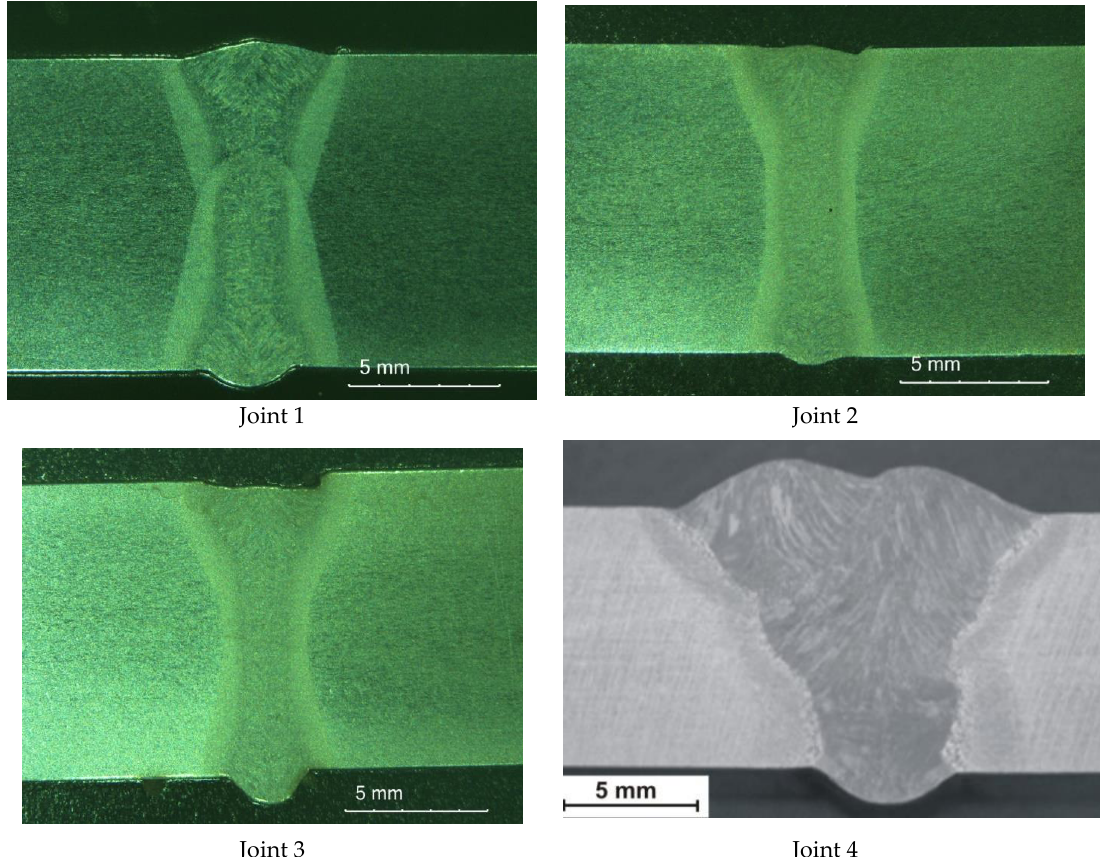
Figure 9. View of the macrostructures of the laser and MAG S700MC steel welded joints.